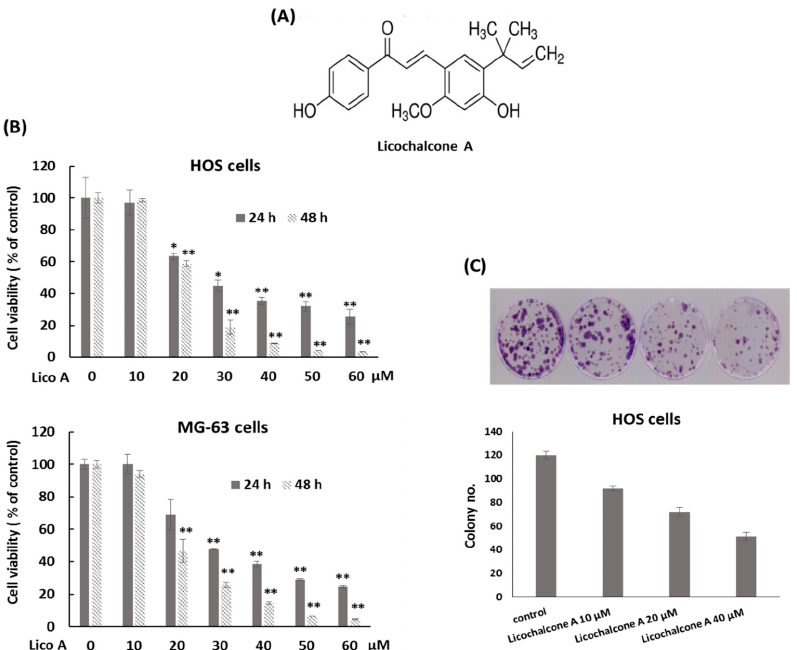
Figure 1. Licochalcone A inhibits cell viability of osteosarcoma. ( A ) The chemical structure of Licochalcone A. ( B ) Licochalcone A inhibits osteosarcoma cell growth in a dose-dependent manner.